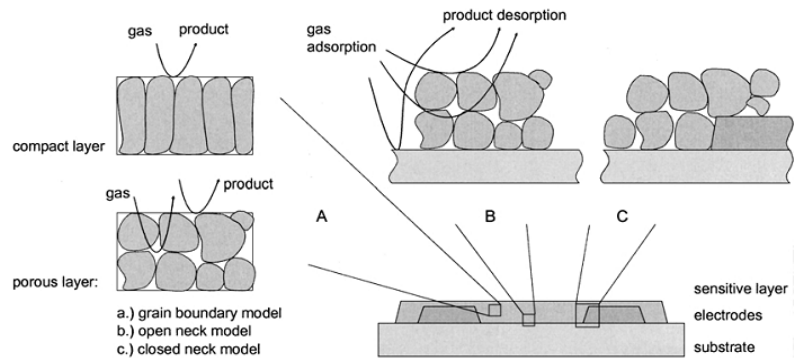
Figure 4. Sensitive layer-target gas interaction, in the case of a resistive gas sensor, from ref. [24].